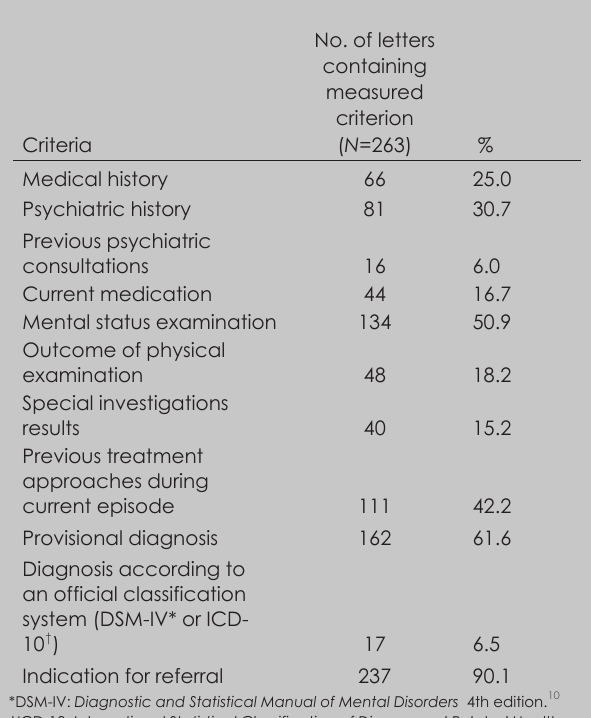
Table IV. Mean checklist scores obtained by the different professional categories of referring practitioners